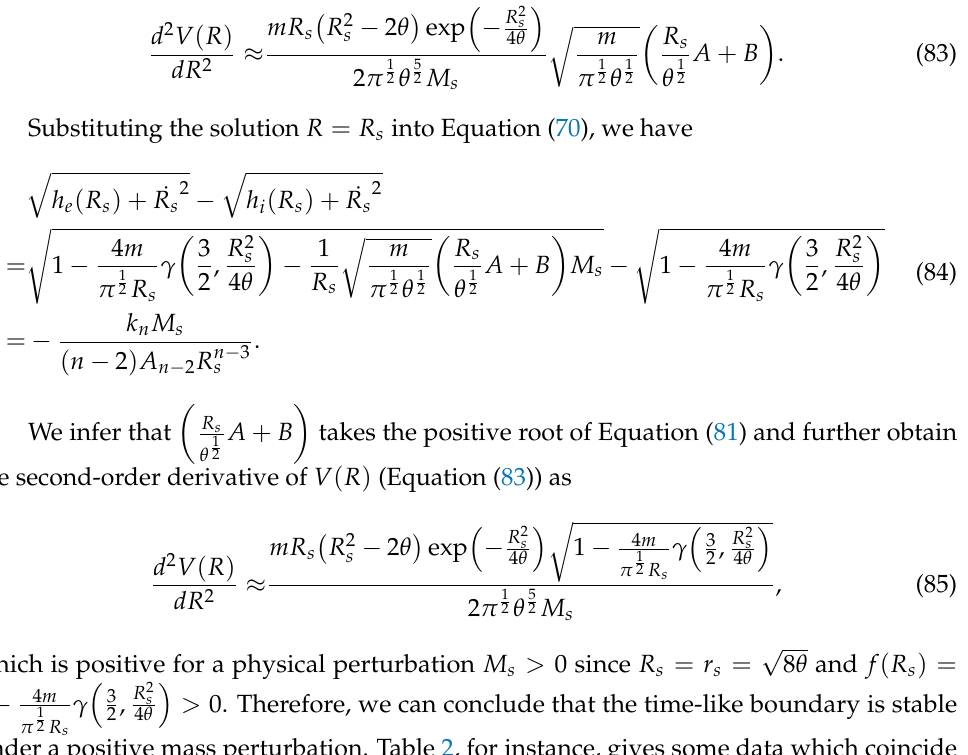
Table 2. The values of physical quantities varied with m : Q 0 and M 0 at M s = 0, and the deviations Q − Q 0 and M − M 0 , and the second-order derivative d √ m /